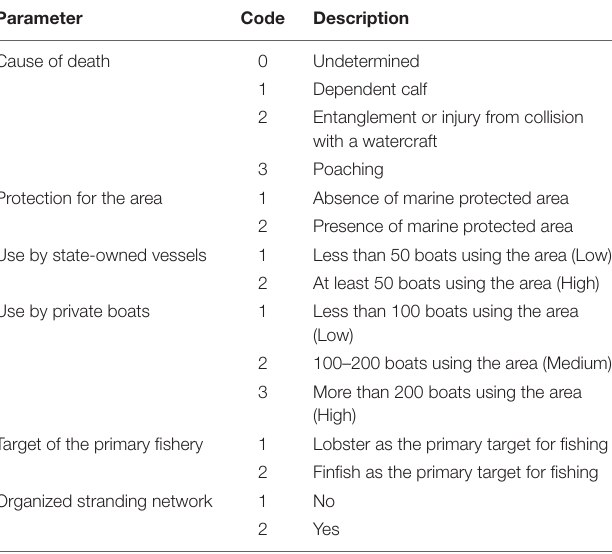
TABLE 1 | Codes created for six parameters that characterize contemporary events affecting manatees in Cuba, with the numeric codes forming the basis for hierarchical clustering of the